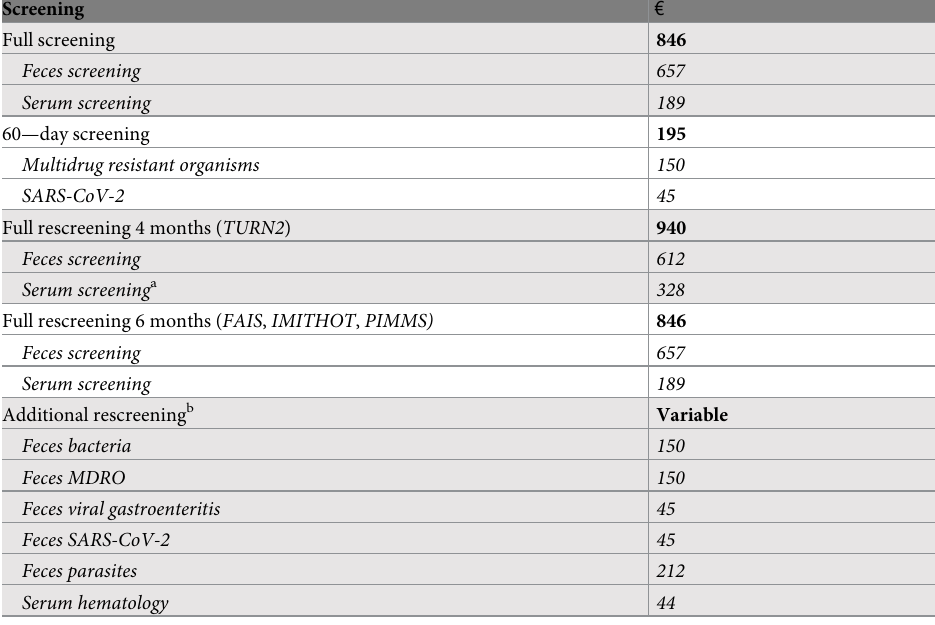
Table 3. Total costs donor screening